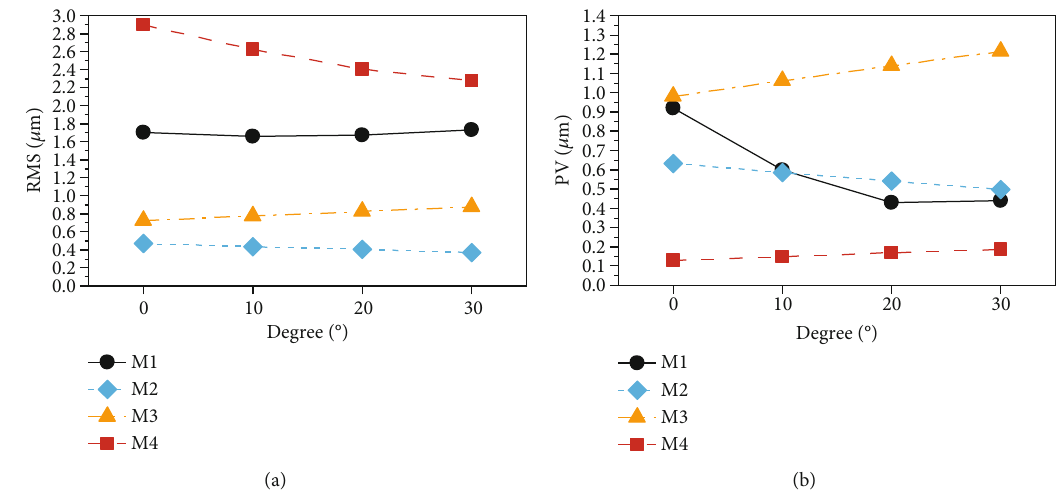
Figure 12: RMS value and PV value: (a) RMS value; (b) PV